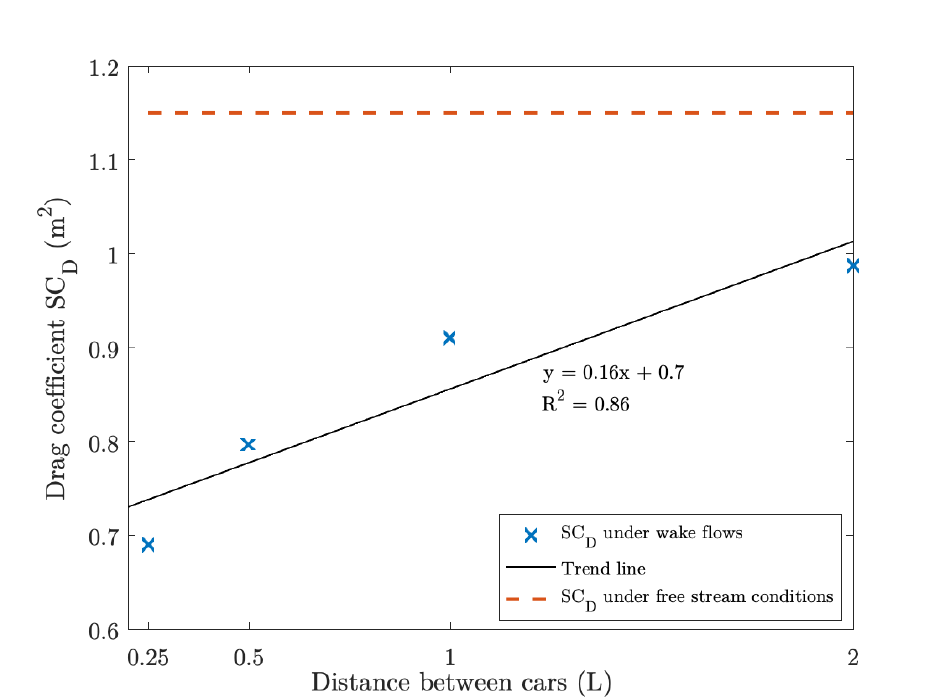
Figure 13. Comparison between values of S C D under wake flows and under free stream conditions.